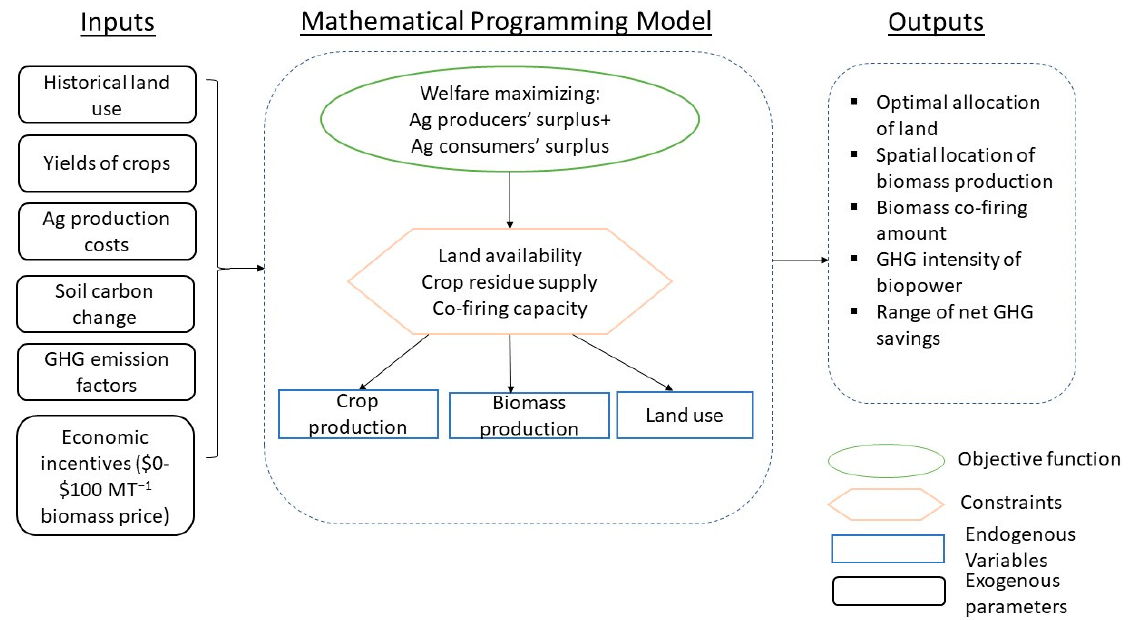
Figure 1. Flow of information within the model.